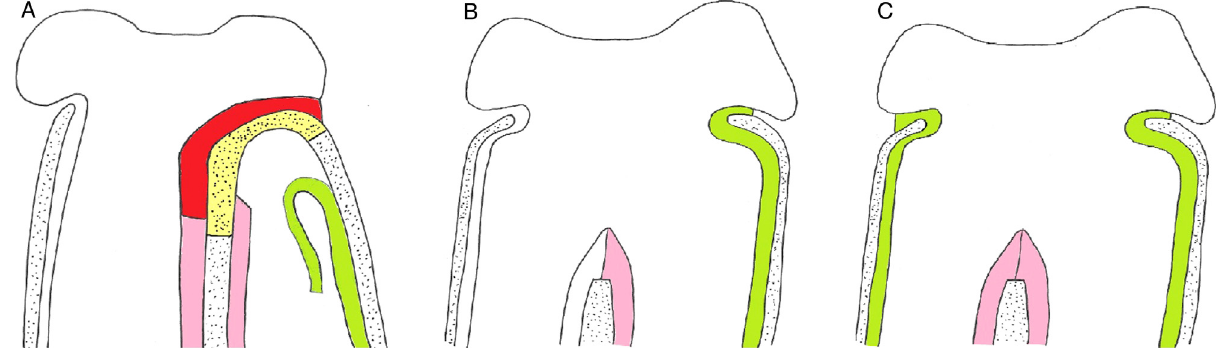
nasopharyngeal aspect with bone biting forceps or micro- drill is carried out (Fig. 4C). 4. Resection of posterior third of the bony septum (vomer, ethmoidal lamina) with back-biting forceps and drill ensues, with bilateral vertical section with angled knife or micro-scissors of the septal mucosa so that only the